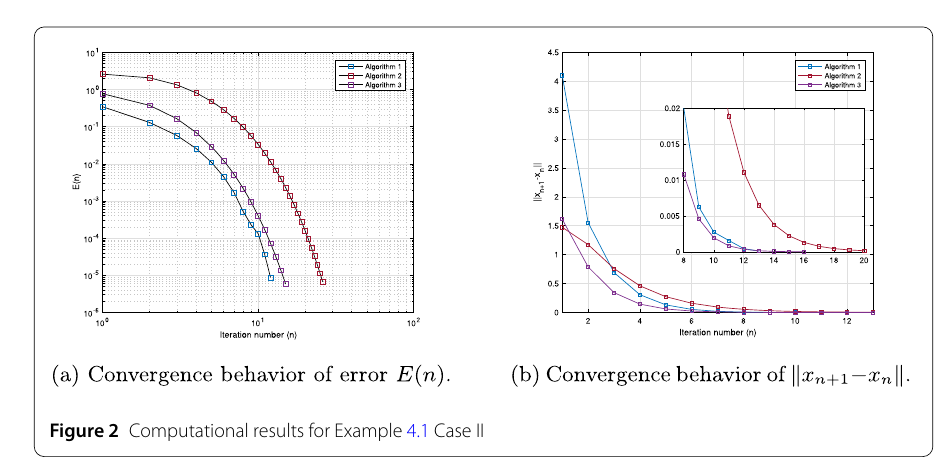
Figure 2 Computational results for Example 4.1 Case II